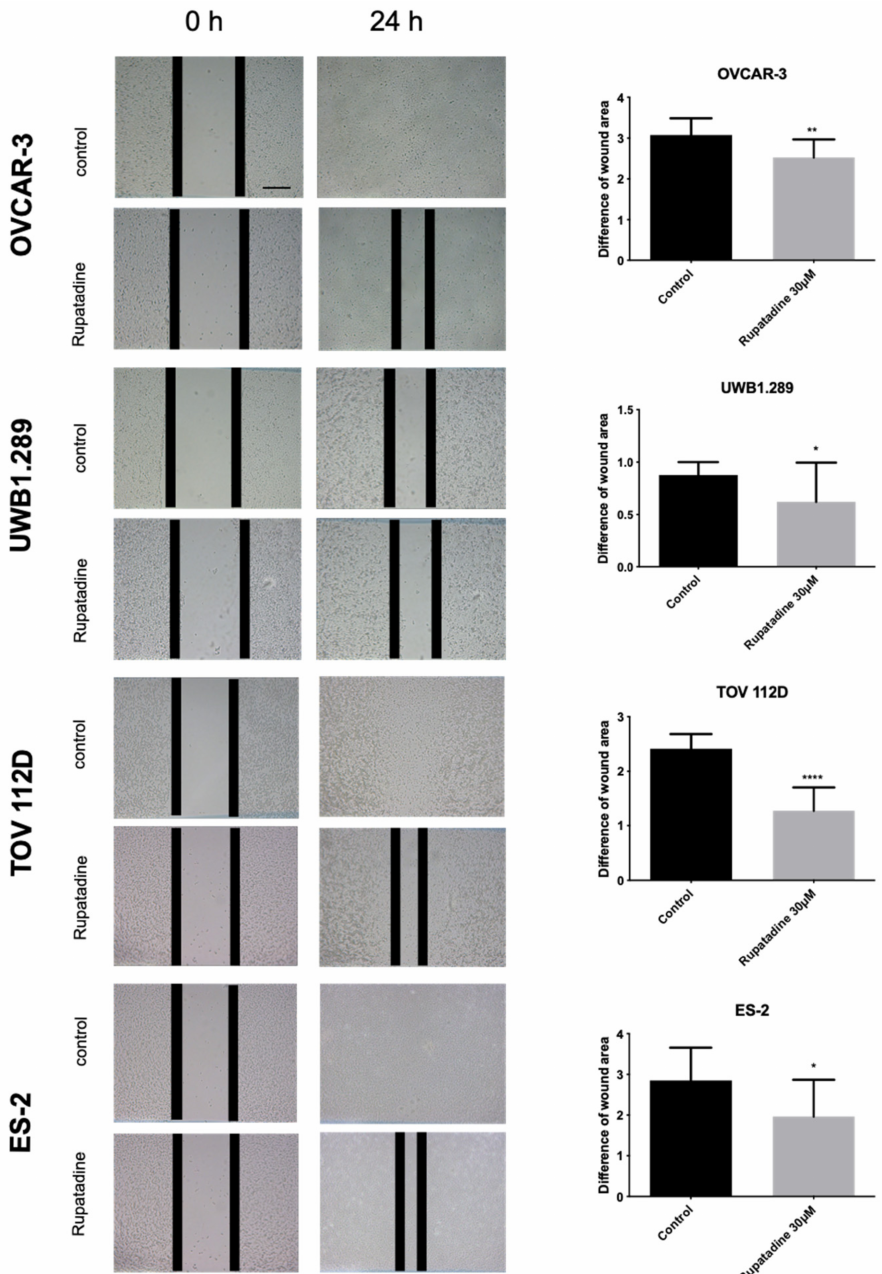
Figure 5. Treatment with rupatadine reduces cell migration of ovarian cancer cells. Wound area was measured at 0 h and 24 h in the control and 30 µ M rupatadine group. Four different ovarian cancer cell lines showed significantly reduced migration after treatment compared to the control group (scale bar: 200 µ m). Columns represent the measured difference of the area covered by cells between 0 h and 24 h. Results are represented as mean (SD) of 3 independent experiments. Unpaired t -test was employed to test for differences between groups and indicated as * p ≤ 0.05, ** p ≤ 0.01, and **** p ≤ 0.0001 compared with